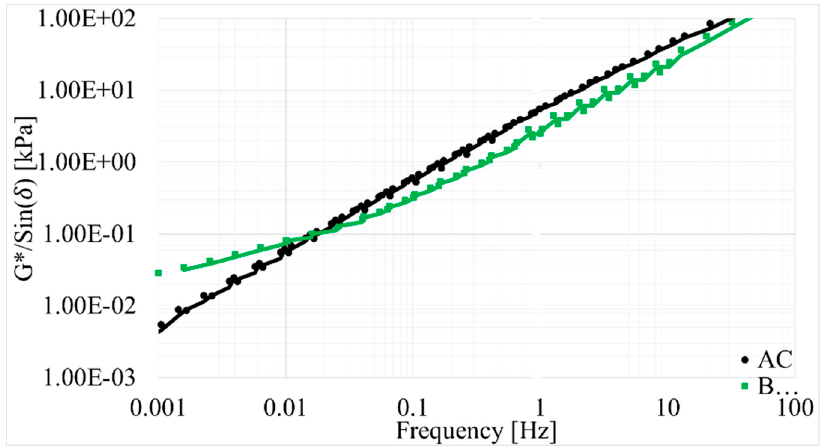
Figure 4. G*/Sin( δ ) master curves of guayule resin vs. original asphalt. Figure 4. G* / Sin( δ ) master curves of guayule resin vs. original